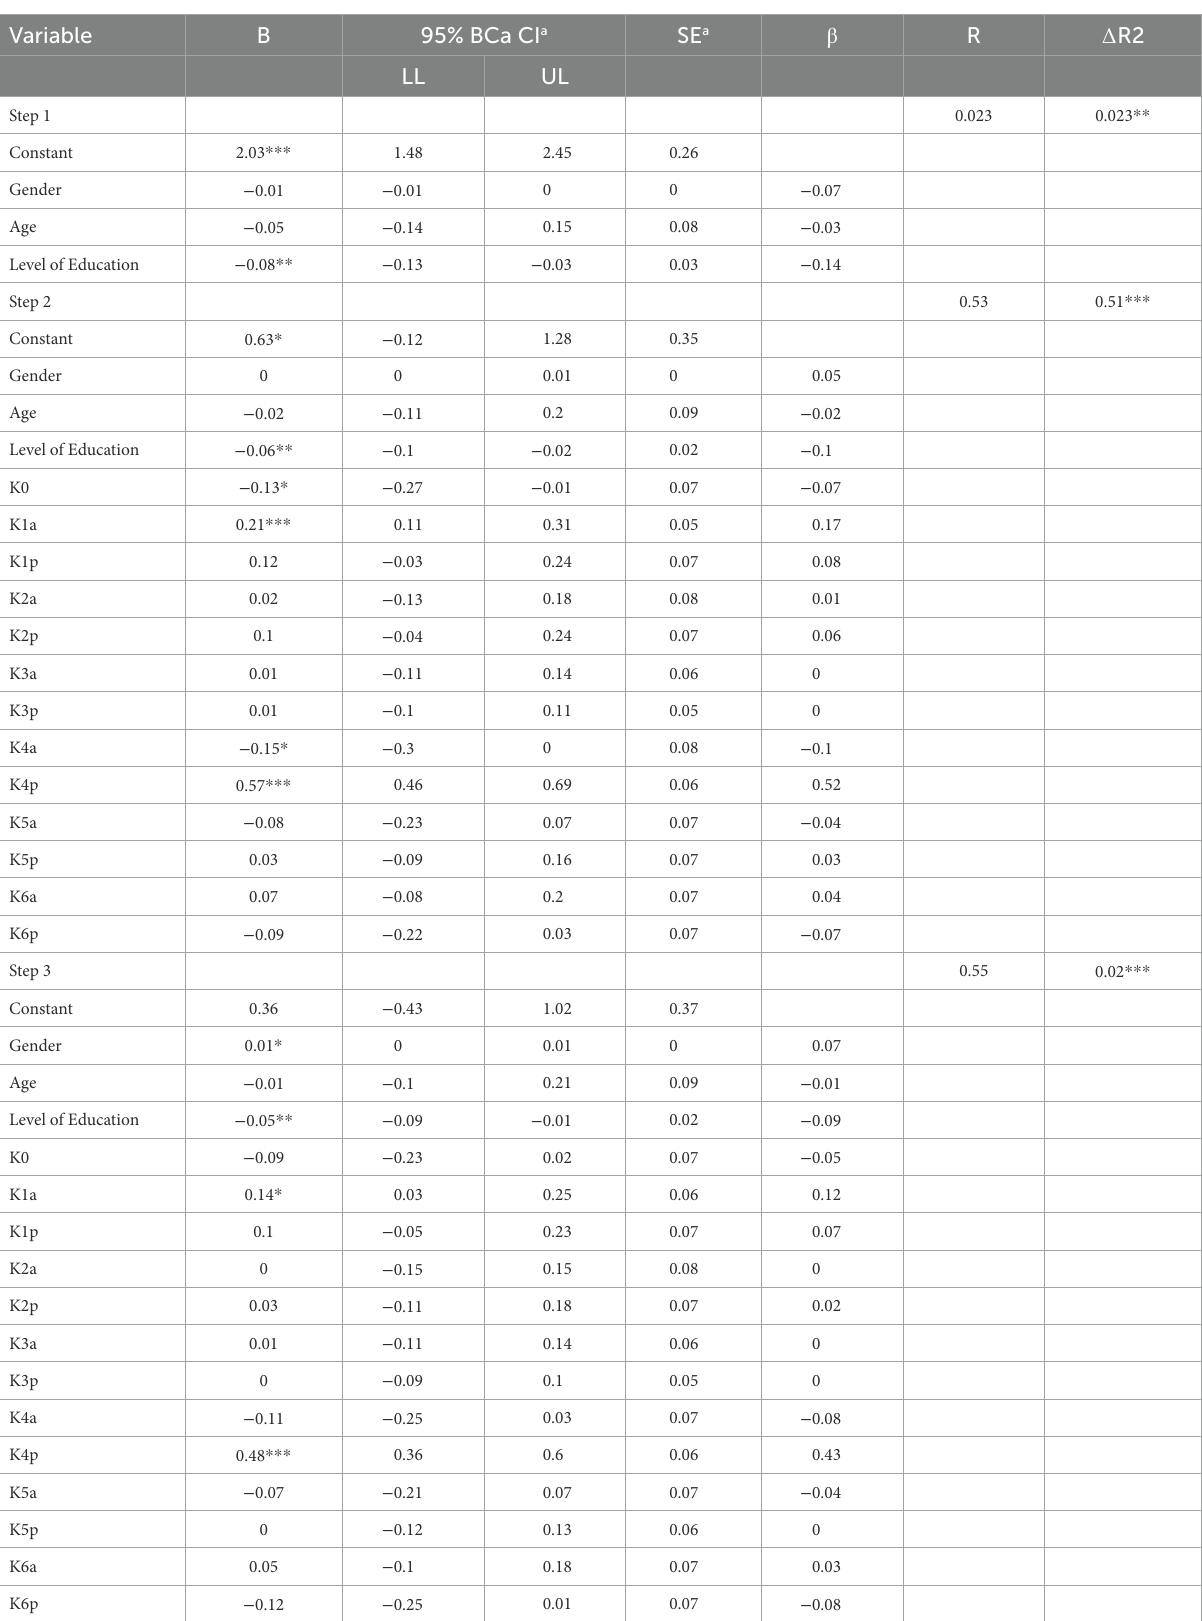
TABLE 6 Hierarchical regression results for burnout